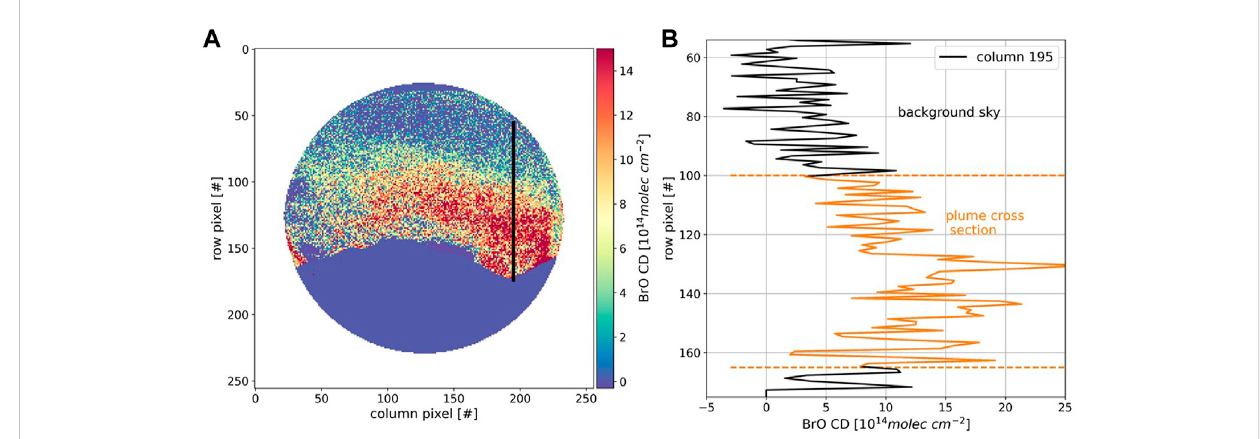
FIGURE 8 (A) BrOCDmeasuredwiththeIFPICSprototypeinstrumentandcalibratedwiththelinearpartofthenarrow-FOVDOASmeasurement(seeFigure7B andFigure9).Theimagehasaspatial resolutionof 200×200pixels and atime resolutionof10 s. Thearea ofthecrater fl ankismasked andsetto zero to enhance the contrast between sky, plume and the crater fl ank. (B) Exemplary plot of column 195 [indicated as black line in (A) ] from image. The volcanic plume signal (between row 100 and 165) in the range of 1.2 × 10 15 molec cm − 2 is clearly distinguishable from the